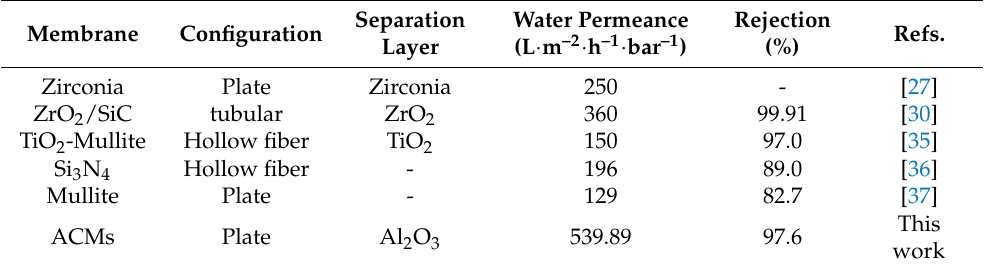
Table 2. Comparison of water flux and oil rejection between ACMs membrane and state-of-the-art ceramic membranes reported in literature.